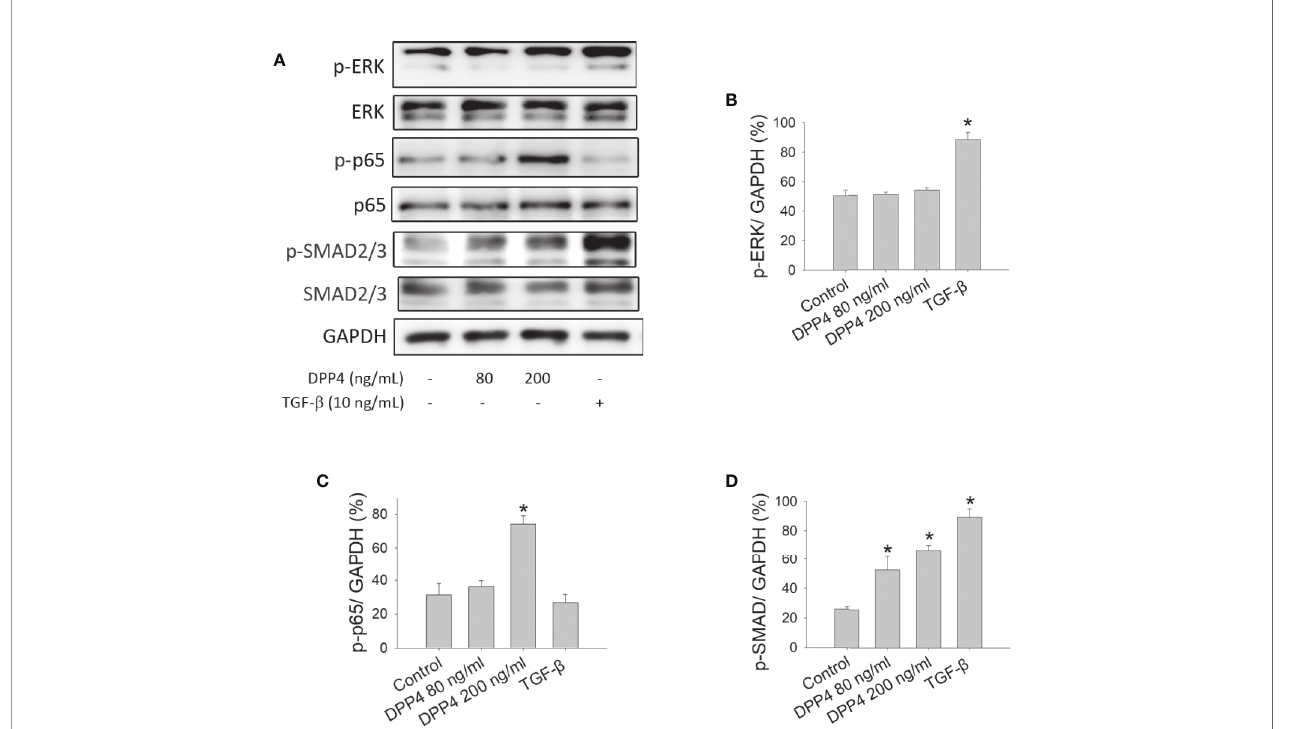
FIGURE 2 | Effects of soluble DPP4 on protein kinases and transcription factors in fi broblasts. Protein expression measured in NIH-3T3 fi broblasts after their treatment with recombinant DPP4 (80 and 200 ng/ml) or TGF- b (10 ng/ml) for 48 h. (A) Protein expression determined using Western blotting. Calculated ratios of (B) p-ERK to GAPDH, (C) p-p65 to GAPDH, and (D) p-SMAD2/3 to GAPDH were shown. (n=4) * p <0.05 vs.